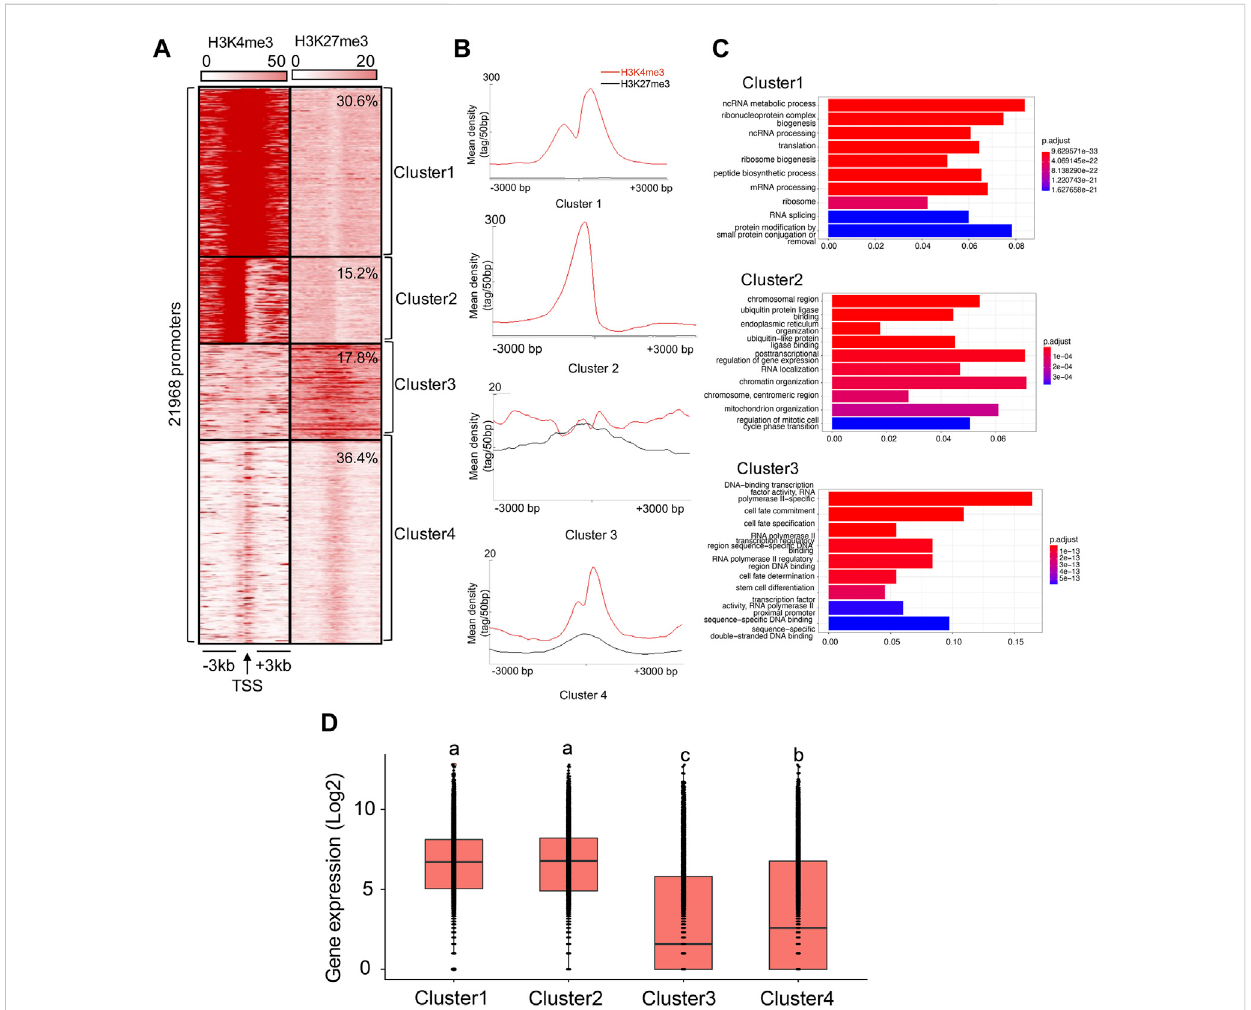
FIGURE 2 Cluster analysis of H3K4me3 and H3K27me3 in the B. dorsalis genome. (A) Heatmap and (B) density pro fi le of the K -means clustering of mapped read position for H3K4me3 and H3K27me3 around TSS regions (±3 kb) in the B. dorsalis genome. (C) Top 10 over-represented GO terms of